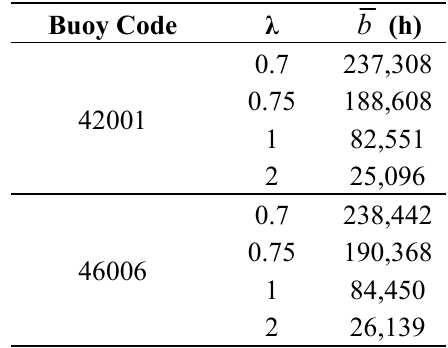
Table 2. Mean base associated with different